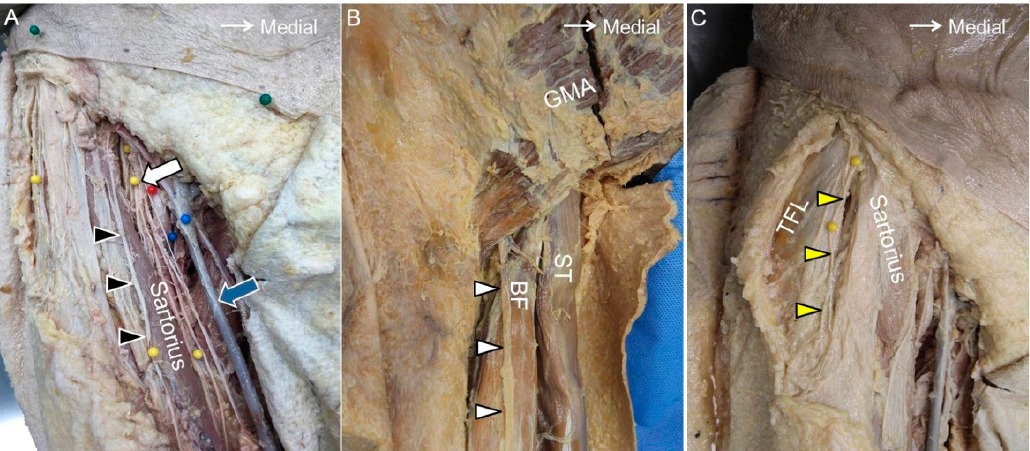
Figure 8. The anterior femoral cutaneous nerve (black arrowhead) at the inguinal region (A) . The posterior femoral cutaneous nerve near the gluteal fold (white arrowhead) (B) . The lateral femoral cutaneous nerve (yellow arrowhead) at the proximal thigh (C) . White arrow, femoral nerve; blue arrow, great saphenous vein; GMA, gluteus maximus muscle; ST, semitendinosus muscle; BF, long head of the biceps femoris muscle; TFL, tensor fasciae latae muscle.